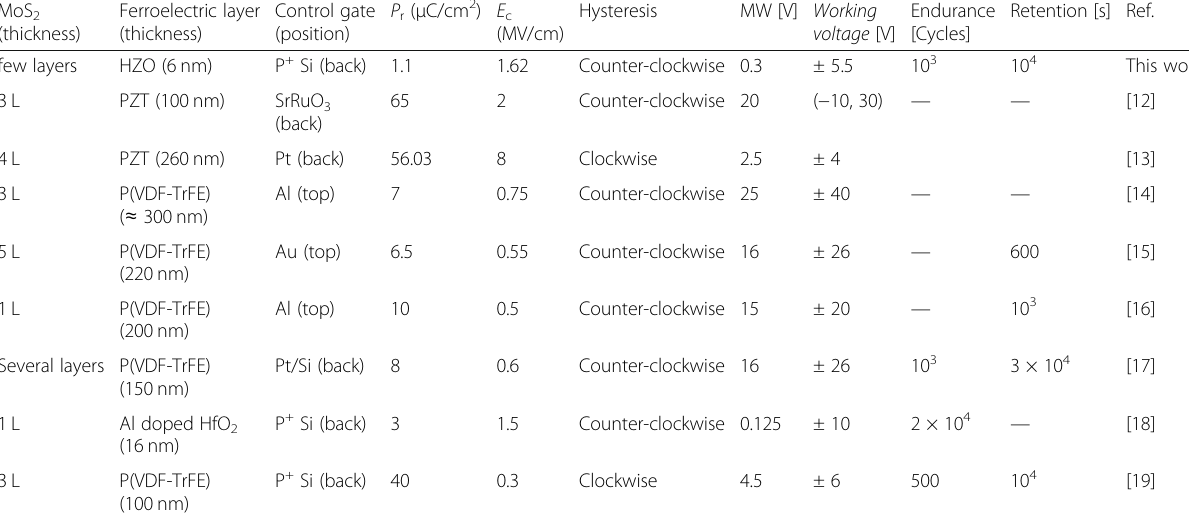
Table 1 Comparison among the figure of merits of ferroelectric FETs based on MoS 2 . MoS 2